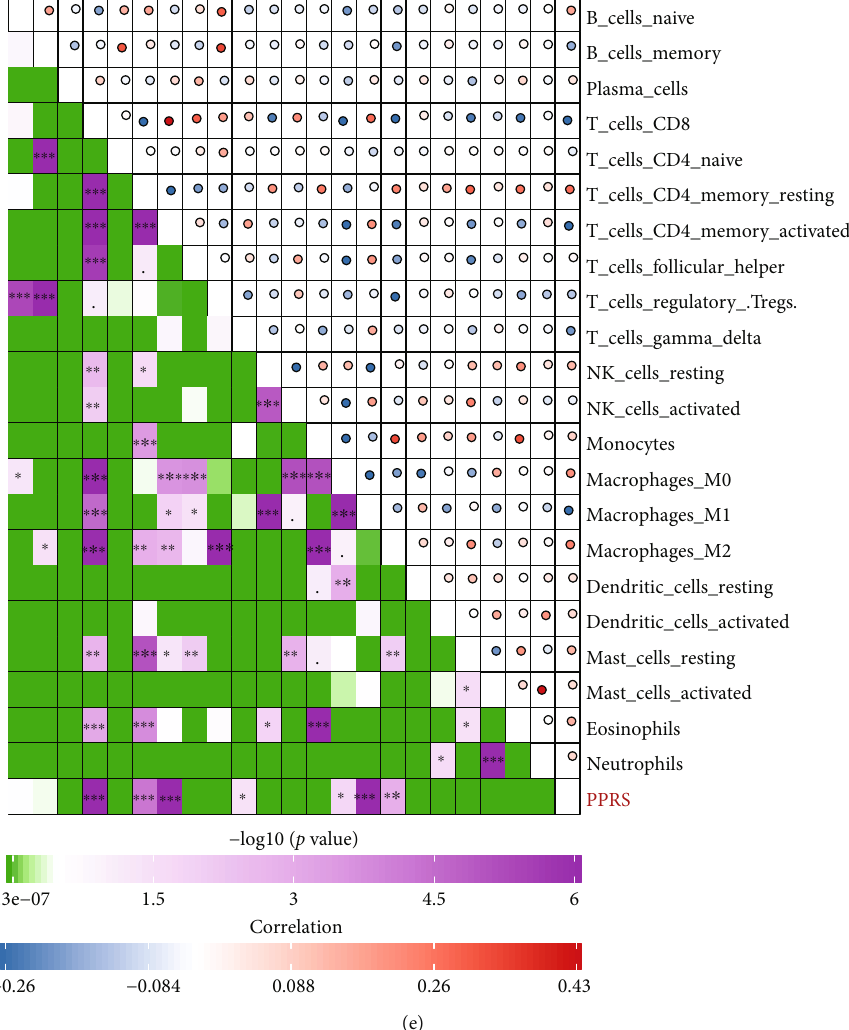
Figure 9: Immune pro fi les of melanoma samples with distinct PPRS score. (a, b) Immune in fi ltration degrees within TIME for melanoma samples from TCGA-SKCM (a) and GSE65904 (b) datasets with high and low PPRS scores by CIBERSORT approach. (c, d) ESTIMATE/ immune/stromal scores for melanoma samples from TCGA-SKCM (c) and GSE65904 (d) datasets with high and low PPRS scores. (e) The relation between immune in fi ltrations and